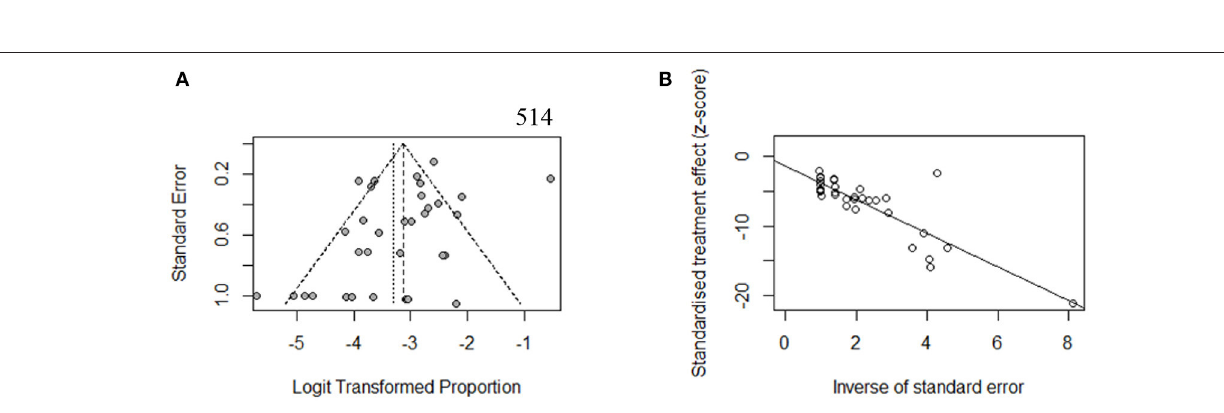
FIGURE 3 | (A) Funnel plot. (B) Egger